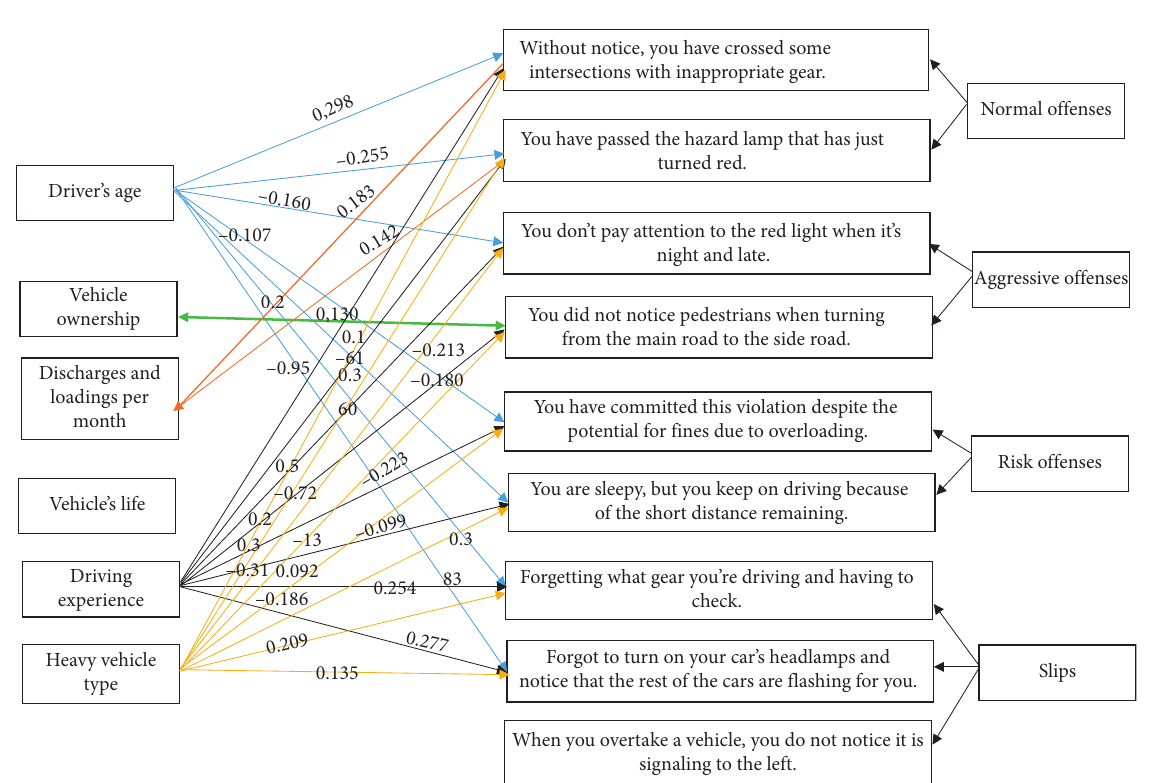
Figure 3: The relationship between independent influential parameters in the utility model and their correlation consequences using the Spearman